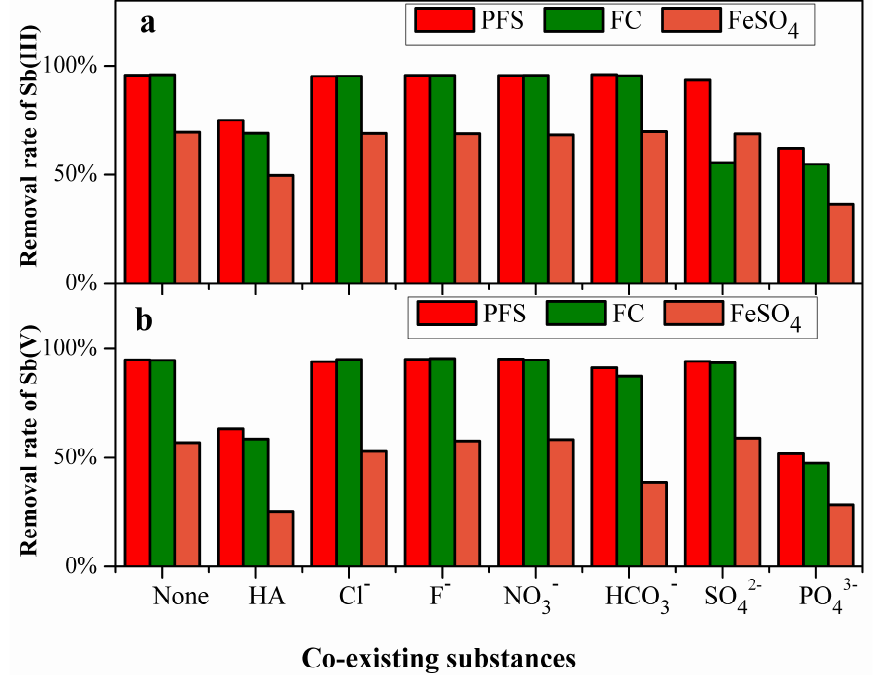
Figure 4. Effects of co-existing substances on the removal of ( a ) Sb(III) and ( b ) Sb(V) (the initial concentrations of Sb(III) and Sb(V): 192 and 205 μg·L −1 , respectively; dosage of PFS as Fe:10 mg·L −1 ).